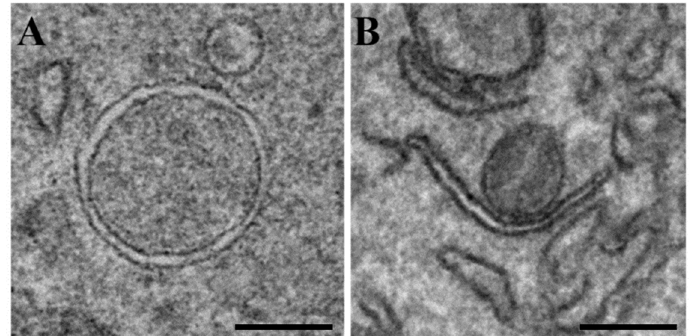
Figure 1. Transmission electron microscopic images of autophagosome ( A ) and isolation membrane ( B ). Neuro-2a (N2a) cells were starved in EBSS for 2 h. Scale bars, 200 nm.